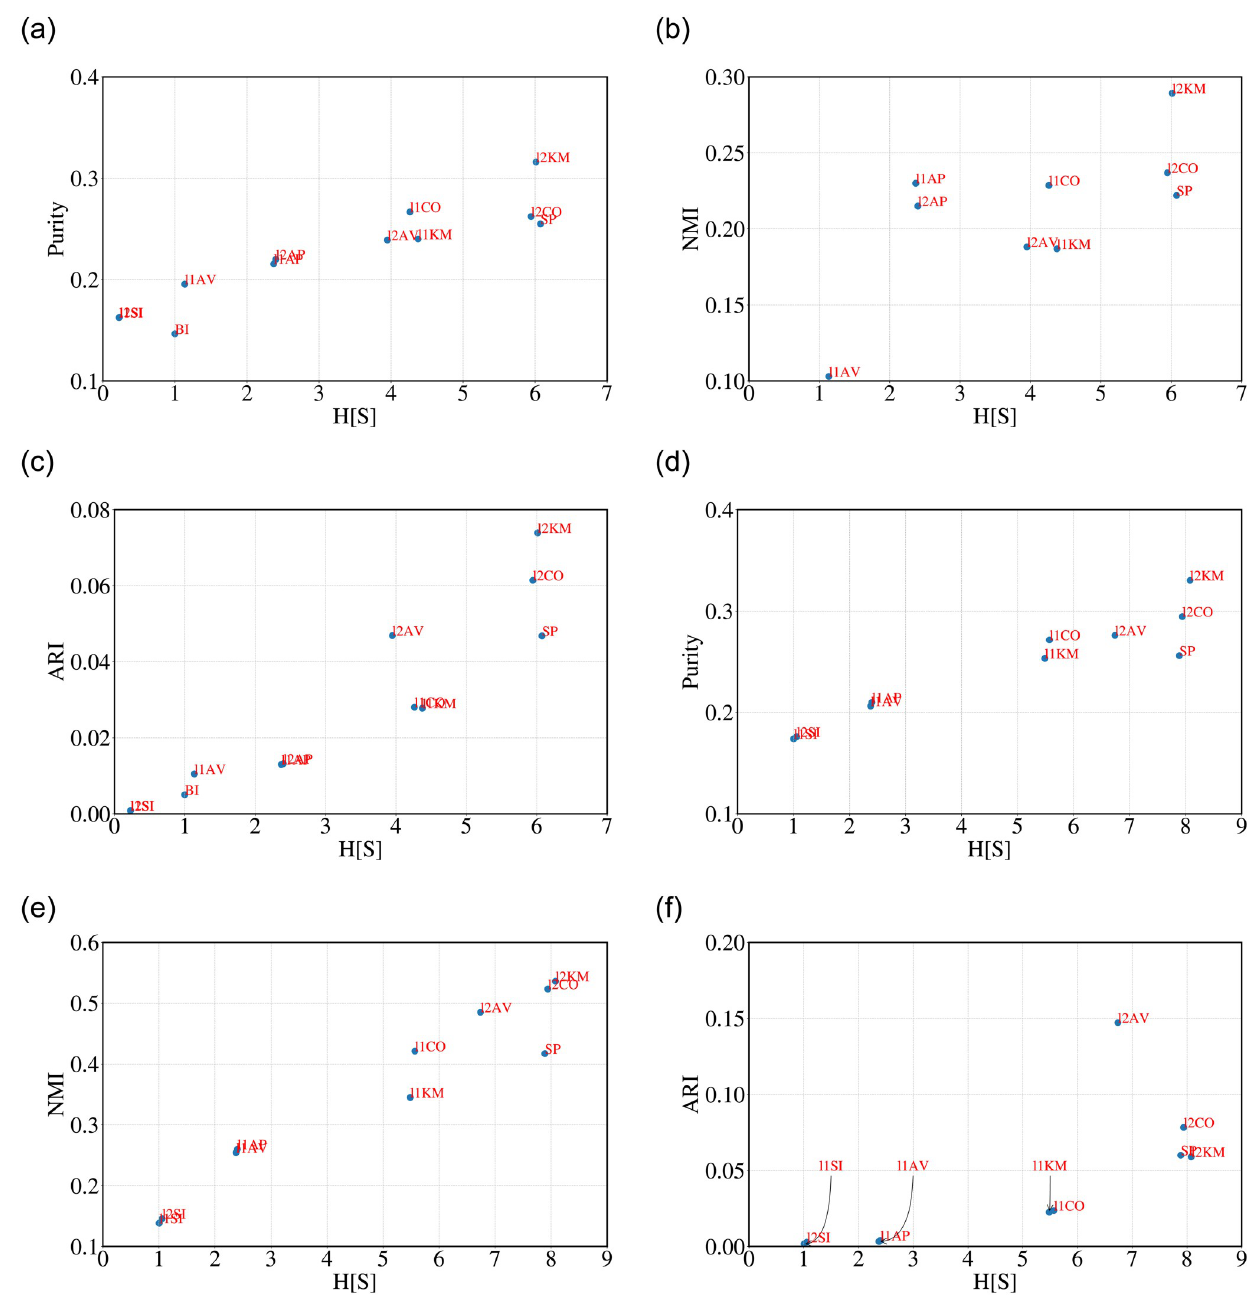
Fig 2. H[S] versus purity, NMI and ARI for the stock dataset, using SEC codes at 2 (top) and 3 (bottom) digits. Different algorithms are represented by a code that depends on the distance metric used (“l1” or “l2”) and the algorithm (SI, AV and CO for single, average and complete linkage, KM for k-means, AP for affinity